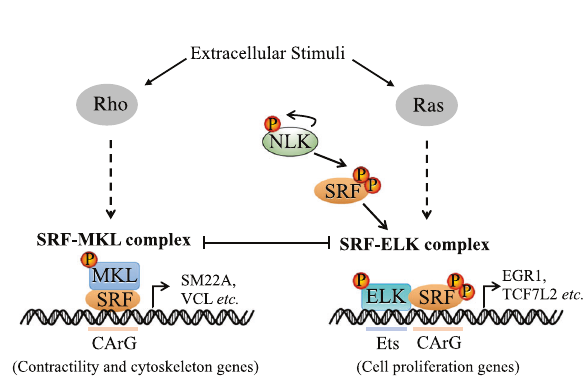
Fig. 8 Conditional NLK knockout leads to mouse skeletal muscle hypertrophy. A , B Identi fi cation of mice with conditional skeletal muscle deletion (Nlk fl / fl HSA-Cre) at the genome, protein ( A ) and mRNA levels ( B ) via genomic PCR, immunoblotting and real-time PCR, respectively ( n = 3). C , D , Mouse, leg ( C ) and skeletal muscle images ( D ) as well as corresponding graphical representation showing increased whole body and skeletal muscle weights for Nlk-de fi cient mice compared with wild-type mice ( n = 6). E Hematoxylin and eosin staining and the corresponding graphical representation showing increased skeletal muscle cell numbers in Nlk-de fi cient mice compared with wild-type mice. Scale bar, 500 μ m. F Real-time PCR showing the gene transcription levels of Egr1, Fos, Vcl, Actg2, Myl9, Tnnc1, Sm22 α , MyoG, MyoD, and MHC in wild-type and Nlk-de fi cient mouse skeletal muscle. The real-time PCR values were normalized to the Gapdh values ( n = 3). G Immunoblotting showing the protein levels of Vcl and Sm22 α in Nlk-de fi cient mouse skeletal muscle compared with wild-type mouse skeletal muscle using the indicated antibodies. Gapdh was used as a loading control. Data are representative of three independent experiments and presented as the mean ± SEM. Statistical signi fi cance was analyzed by ANOVA (* p < 0.05, ** p < 0.01, *** p < 0.001, **** p < 0.0001). IB immunoblotting, GAS gastrocnemius. Source data ( A – G ) are provided as a source data fi le.